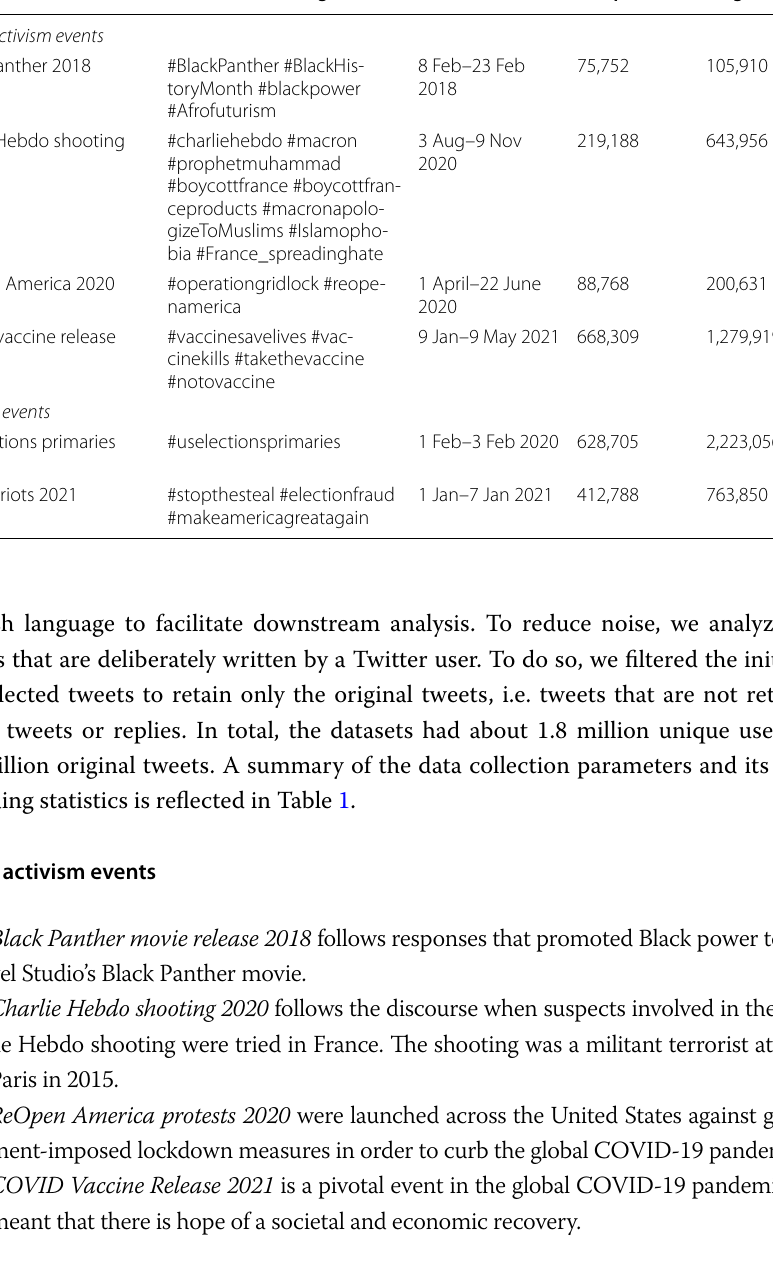
Table 1 Summary of data used in this study